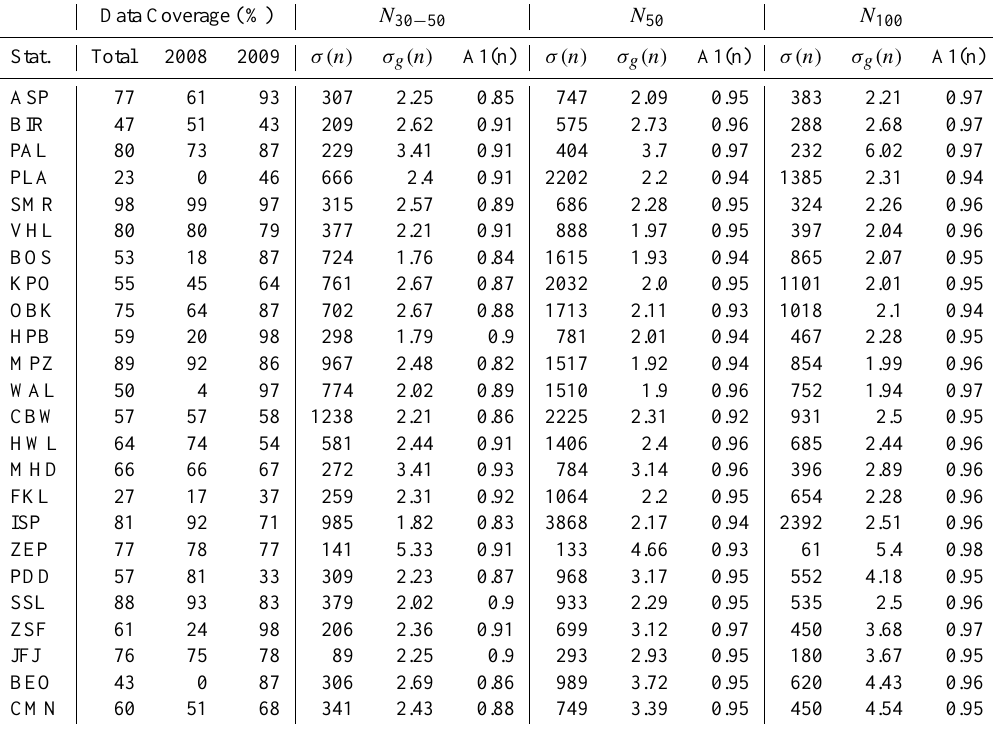
Table 5. Data coverage and standard deviations ( σ(n) , incm − 3 ), geometric standard deviations ( σ g (n) , unitless) and 1-h autocorrelation rates (A1, unitless) of